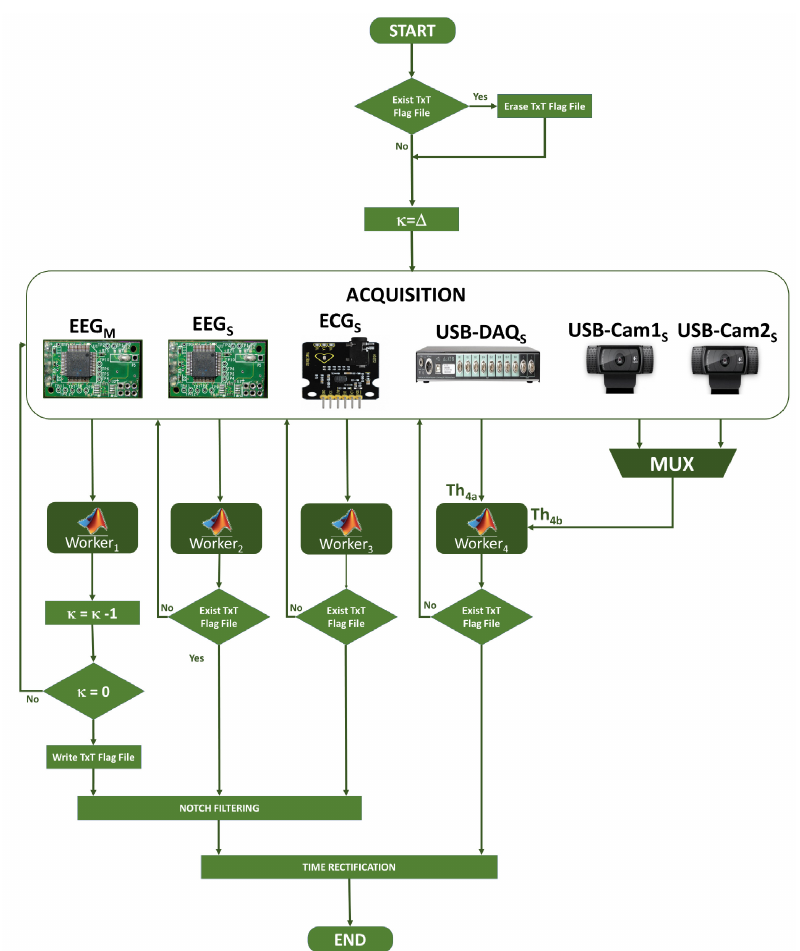
Figure 14. General Algorithm of System for monitoring biomedical signals using parallel